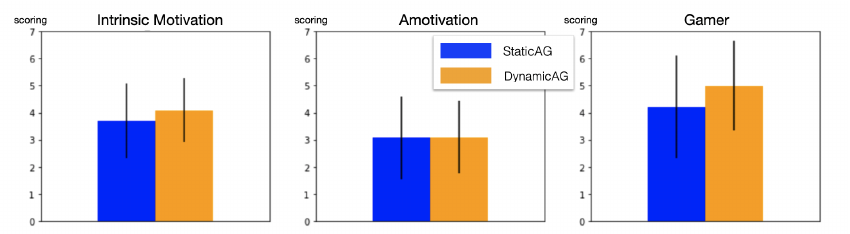
Figure 4. Test of the initial motivation of both experimental groups: DynamicAG and StaticAG. Measures: IM—Intrinsic Motivation, A—Amotivation,